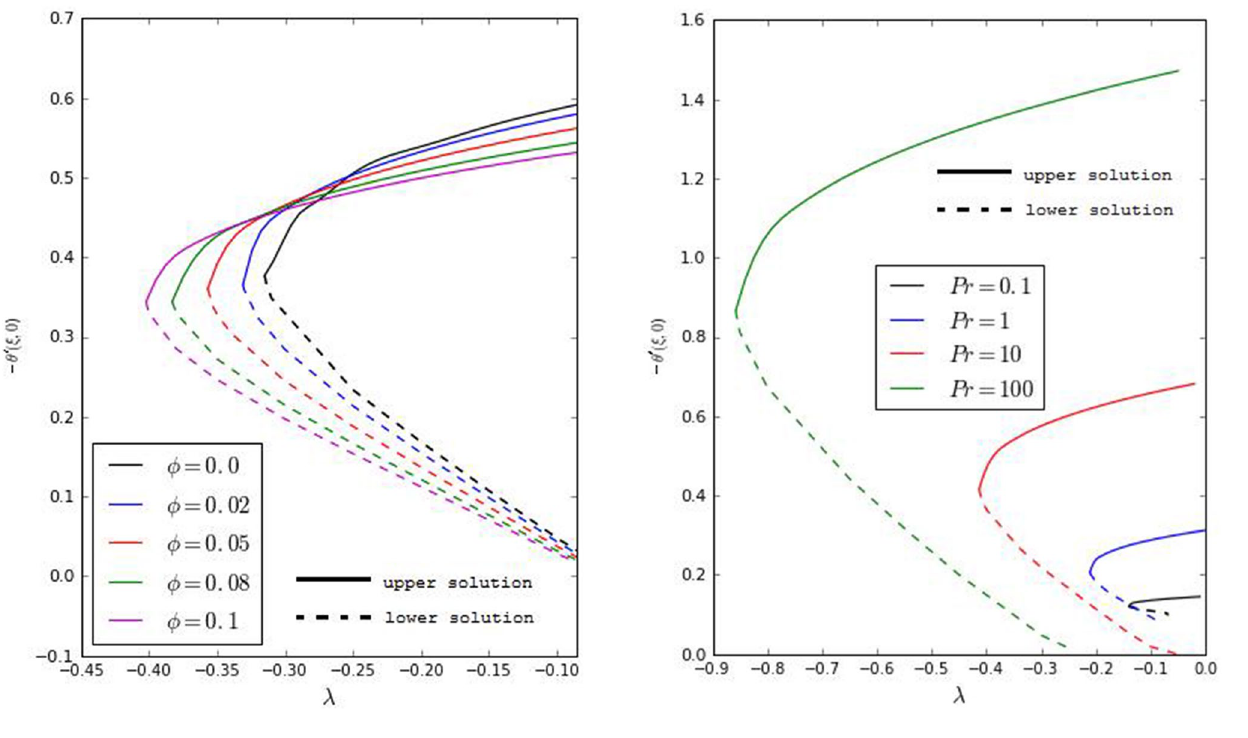
Fig. 5 Profiles for − 𝜃 � ( 𝜉 ,0 ) for 𝜙 = 0,0.02,0.05,0.08 and 0.1 with fixed Pr = 6.7 for 𝜆 < 0